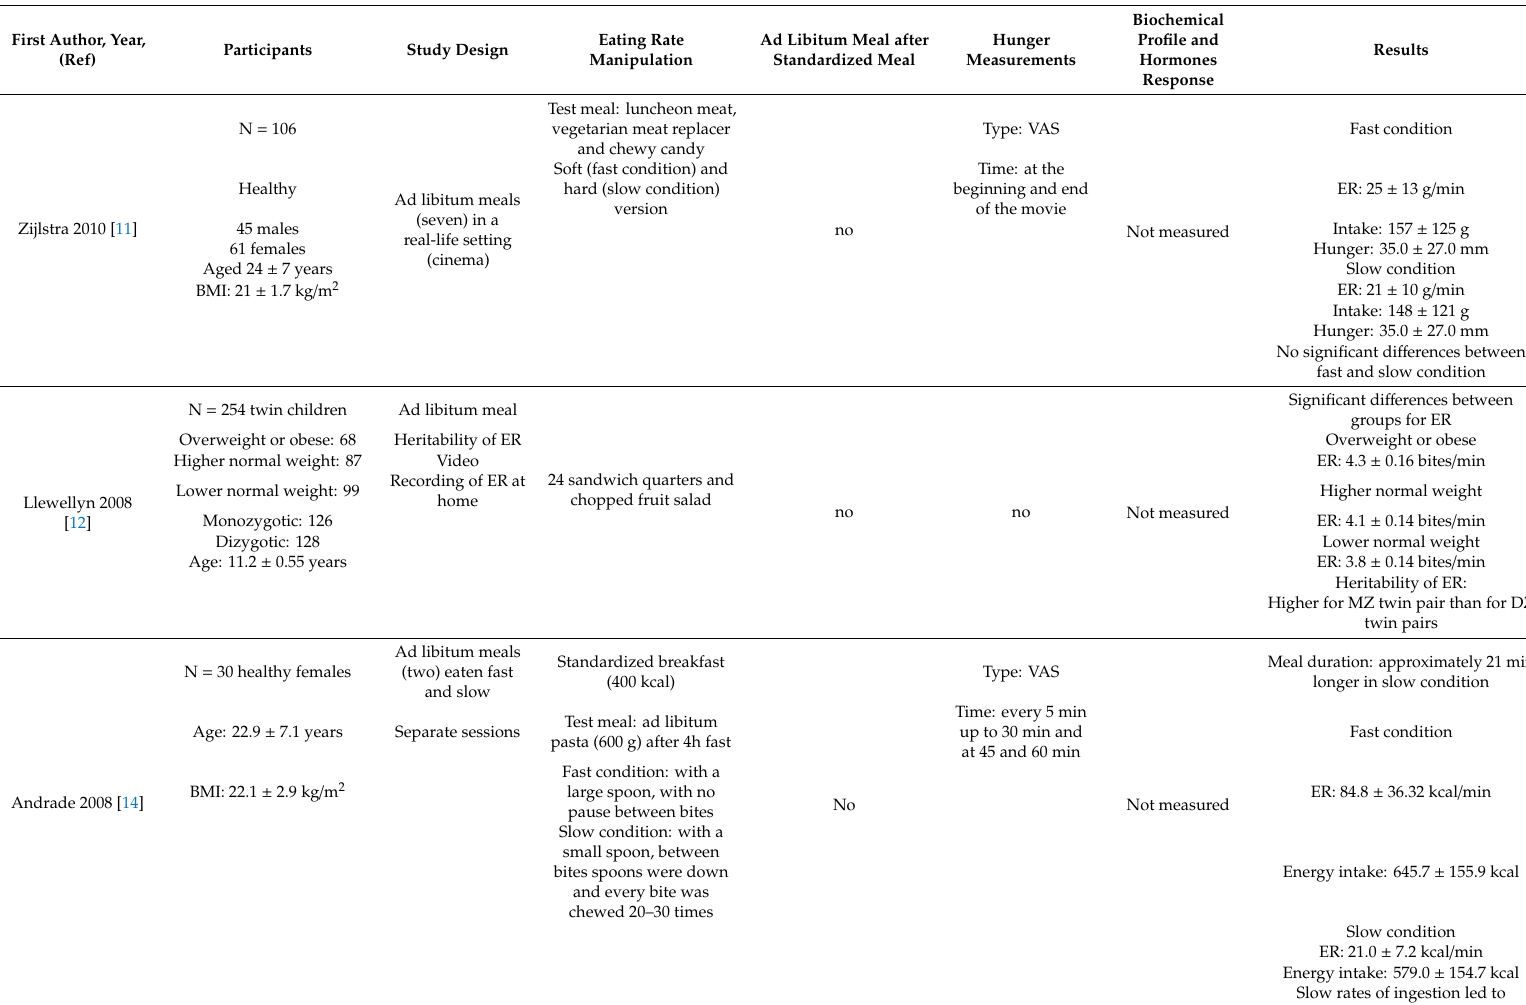
Table 1. Studies examining the e ff ect of manipulating eating rate, food texture, and mastication speed in healthy